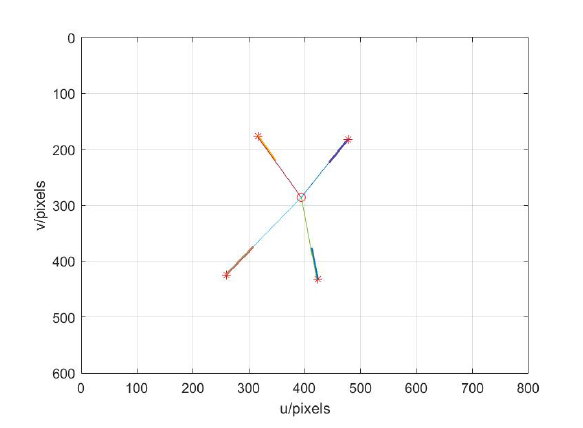
Figure 2. Image paths of four points and the calibrated principle